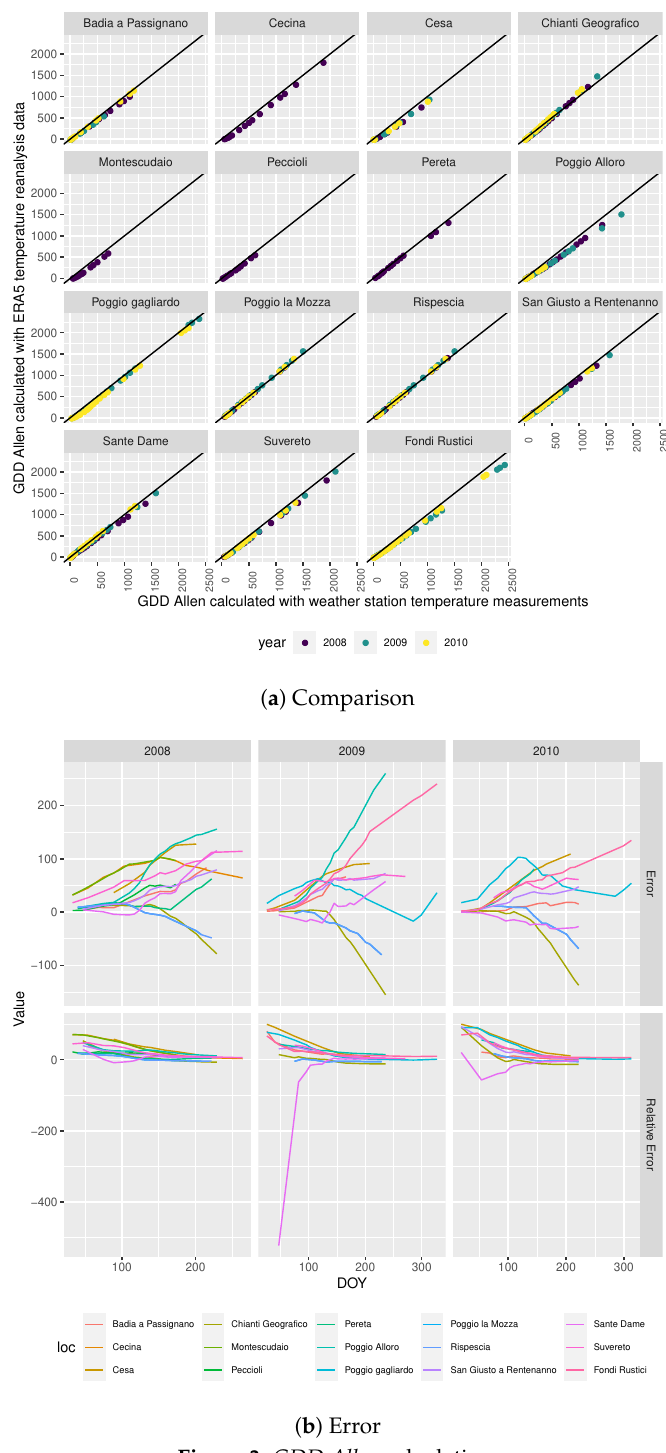
Figure 3. GDD Allen